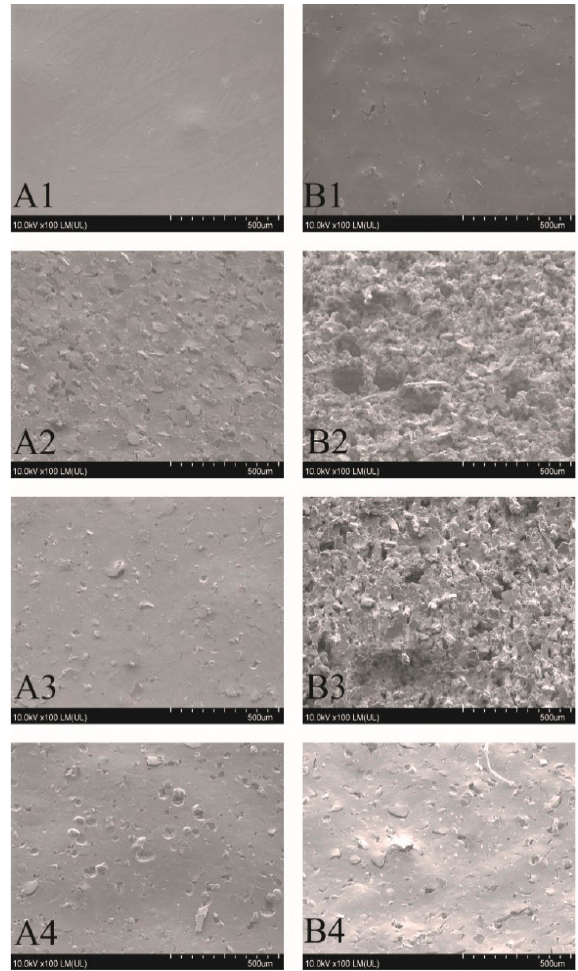
Figure 7. SEM images of coatings after electroless metallization. On the coatings where the copper layer has been obtained, the surface structure of the deposited layer is strongly developed, and to some extent reflects the structure obtained after laser irradiation. The Sb 2 O 3 particles exposed as a result of laser irradiation after the metallization process were covered with a copper layer (B2 and B3 coatings) (Figure 8). In the case of samples where the electroless metallization process was not successful, the surface structure reflected the structure after the laser irradiation process.